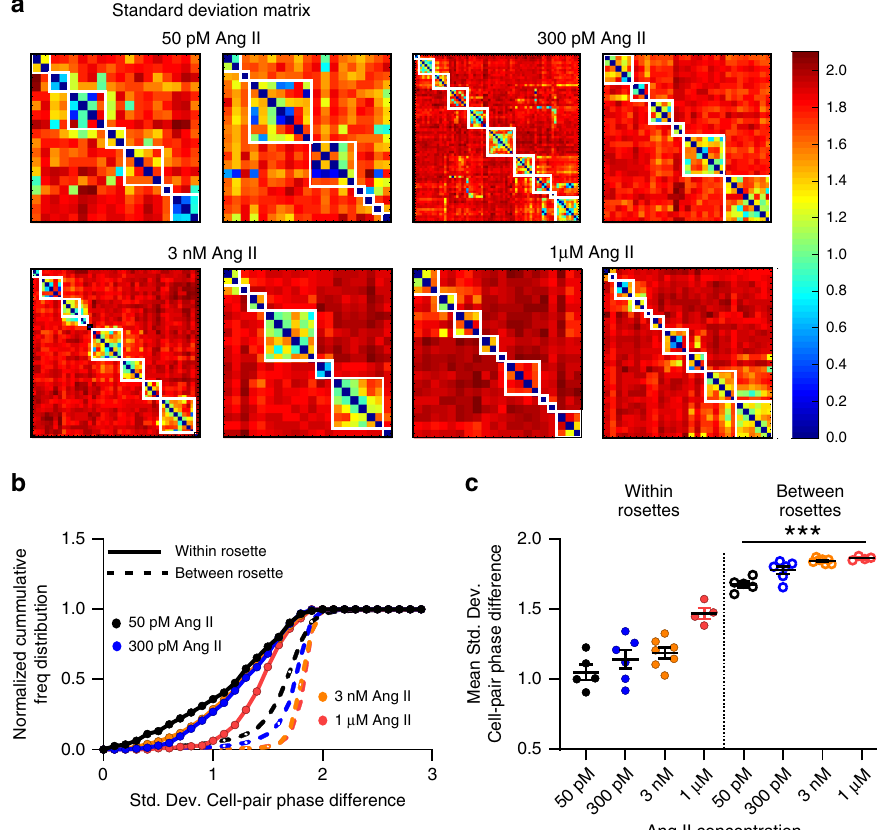
Fig. 6 Ang II-induced calcium spikes have phase-stability among rosette members. a Two representative phase analyses of calcium spikes shown in matrix plots for each Ang II concentration. Individual cells are ordered along the X - and Y -coordinates; each square of the matrix represents the standard deviation of phase difference (PD-STDEV) between two cells and is color-coded (blue: low PD-STDEV; red: high PD-STDEV). White boxes delineate individual rosettes. Dark blue diagonal across each plot corresponds to self-pairing. Phase-locking is greater among cells within rosettes than between rosettes, as indicated by more blue/green hues, a leftward shift in the cumulative phase distribution ( b ) and an overall smaller mean PD-STDEV ( c ) (within-rosette mean PD-STDEV± SEM: 50pM: 1.05 ± 0.055, 300 pM: 1.14 ± 0.065; 3 nM: 1.19 ± 0.039; 1 µ M: 1.47 ± 0.039; between-rosette mean PD- STDEV± SEM: 50 pM: 1.68 ± 0.022, 300 pM: 1.78 ± 0.028; 3 nM: 1.85 ± 0.007; 1 µ M: 1.86 ± 0.007; 1-way ANOVA P ≤ 0.0001; within-rosette mean PD- STDEV for each dose differed signi fi cantly from every dose between-rosette mean PD-STDEV [*** P ≤ 0.037]). b , c Lines and symbols are color coded according to experimental condition; 50 pM: black, 300 pM Ang II: blue, 3 nM Ang II: orange, 1 µ M Ang II: red. Source data are provided as a Source Data fi fi elds of one cell in fl uence closely apposed cells 34 , or via mechanical transmission when membrane stress imposed on morphologically tethered cells is shared 35,36 . We therefore tested whether close proximity regulates zG calcium bursts.